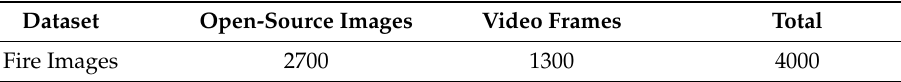
Table 1. Allocation of fire images in the dataset.